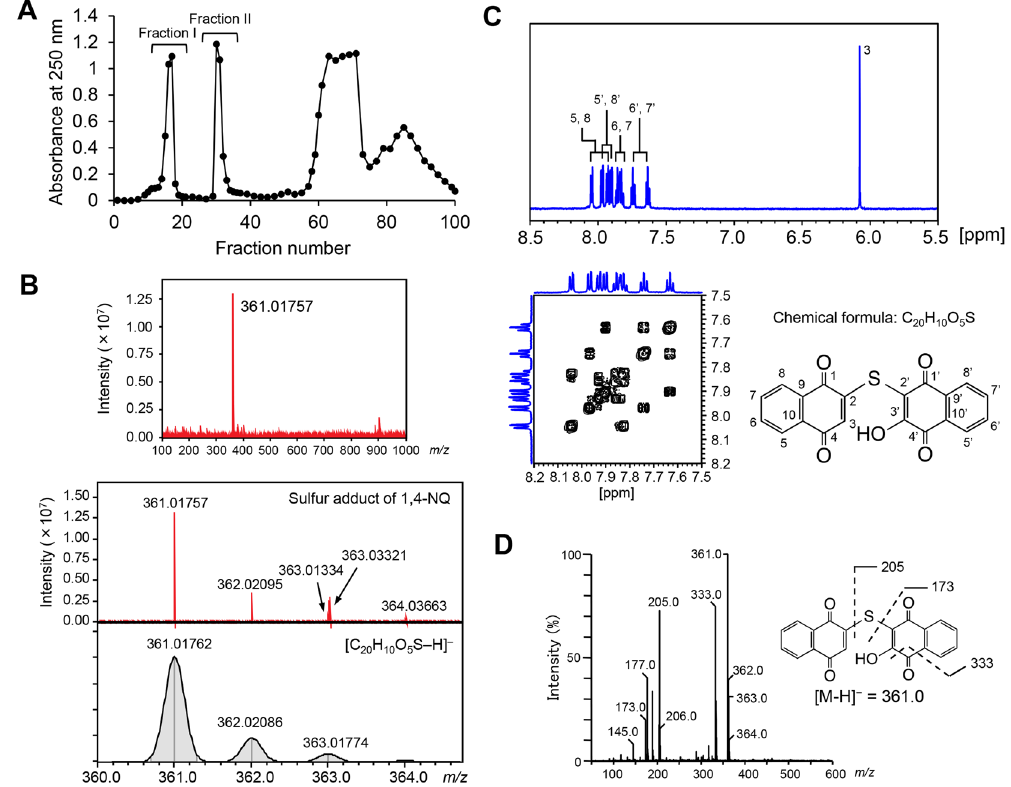
Figure 4. Purification and identification of the sulfur adduct of 1,4-NQ. ( A ) Separation of sulfur adducts of 1,4-NQ by column chromatography. 1,4-NQ (5 mM) was incubated with Na 2 S 4 (10 mM) for 10 min at room temperature. The resulting solution was applied to an ODS column and eluted with 20% acetonitrile for 40 min followed by 80% acetonitrile for 60 min at a flow rate of 10 mL/min. Each fraction was analyzed by UV absorbance at 250 nm and by UPLC-MS. Fraction II primarily contained m/z 361 in negative ion mode. ( B ) FT-ICR-MS of the purified sulfur adduct. ESI-MS spectrum of the reaction product with m/z 361 (upper) and comparison of isotope ratios between the product and an elemental composition of C 20 H 10 O 5 S (lower). ( C ) Magnified views of the 1 H NMR (upper) and 1 H- 1 H COSY NMR (lower) spectra of a sulfur adduct of 1,4- NQ with m/z 361. Four doublet proton signals at δ 8.05 (d, J = 3.7 Hz, 1 H), 7.97 (d, J = 3.6 Hz, 1 H), 7.93 (d, J = 3.7 Hz, 1 H) and 7.91 (d, J = 5.8 Hz, 1 H), and four triplet proton signals at δ 7.86 (t, J = 7.4 Hz, 1 H), 7.83